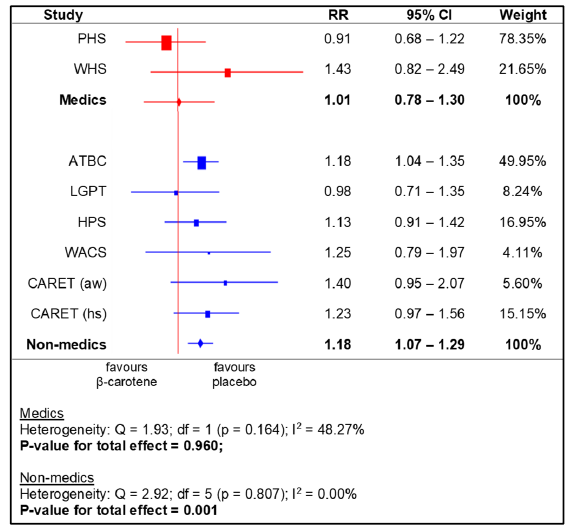
Figure 7. Meta-analysis for subgroups (medical professionals)—lung cancer incidence depending